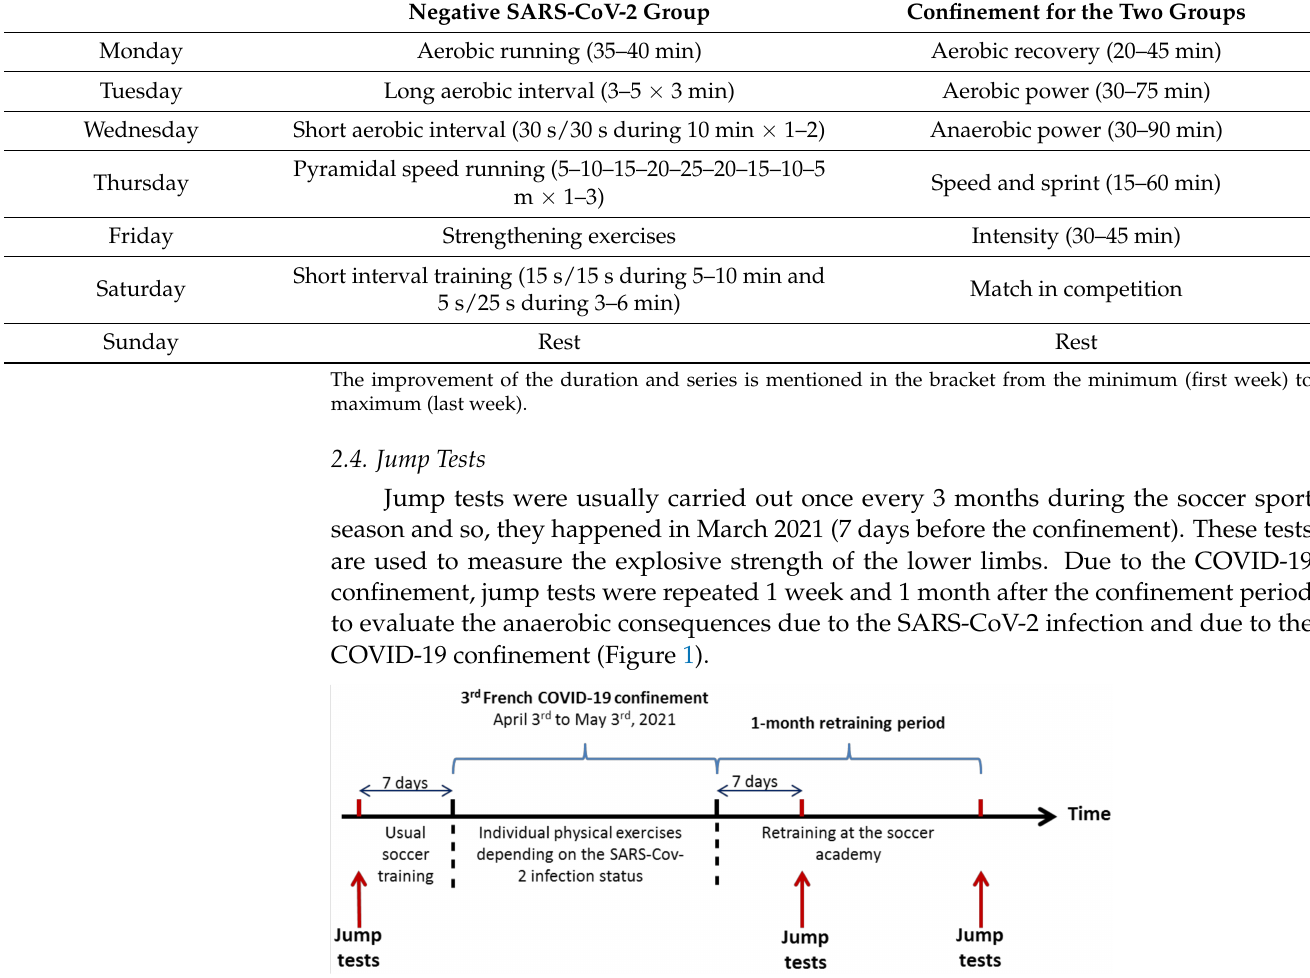
Figure 1. Experimental scheme of jumps